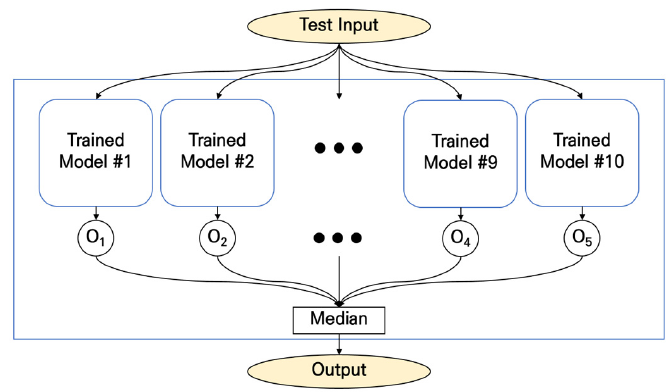
Figure 5. Ensemble method.